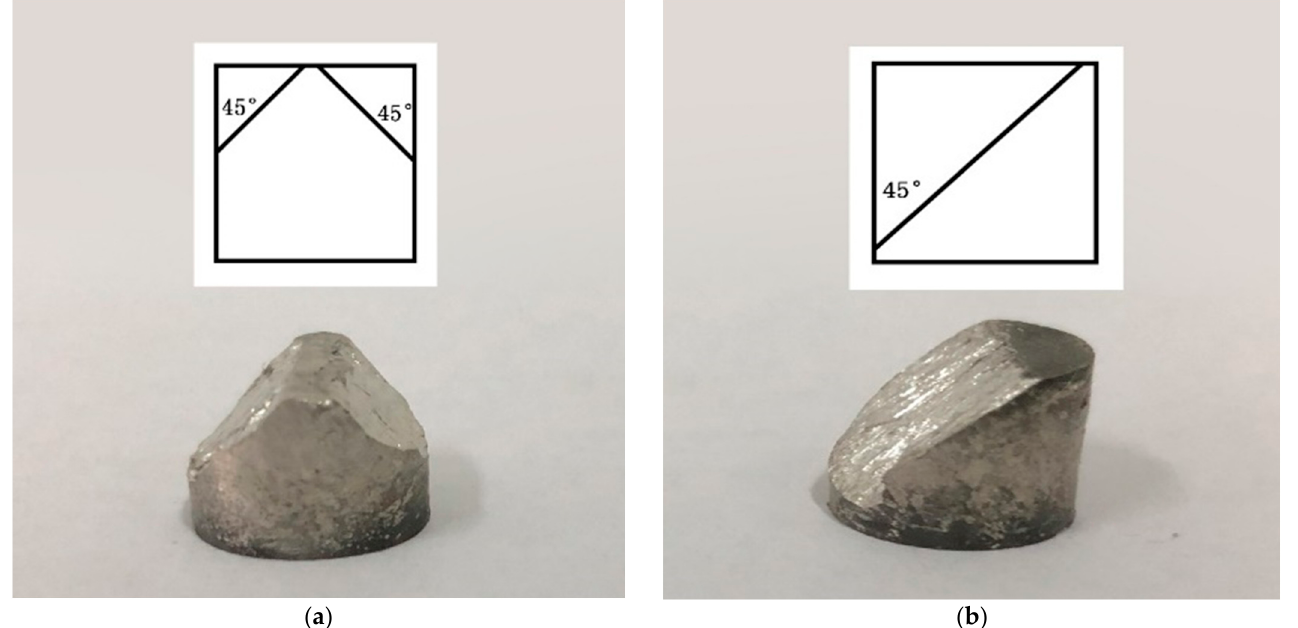
Figure 13. Macroscopic morphology of Mg-Al-Ca-Mn alloy fractured in ( a ) ND and ( b ) vertical 45° direction.